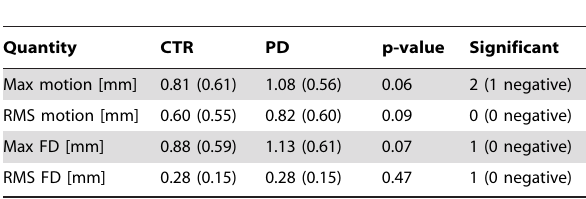
Table 6. Head motion